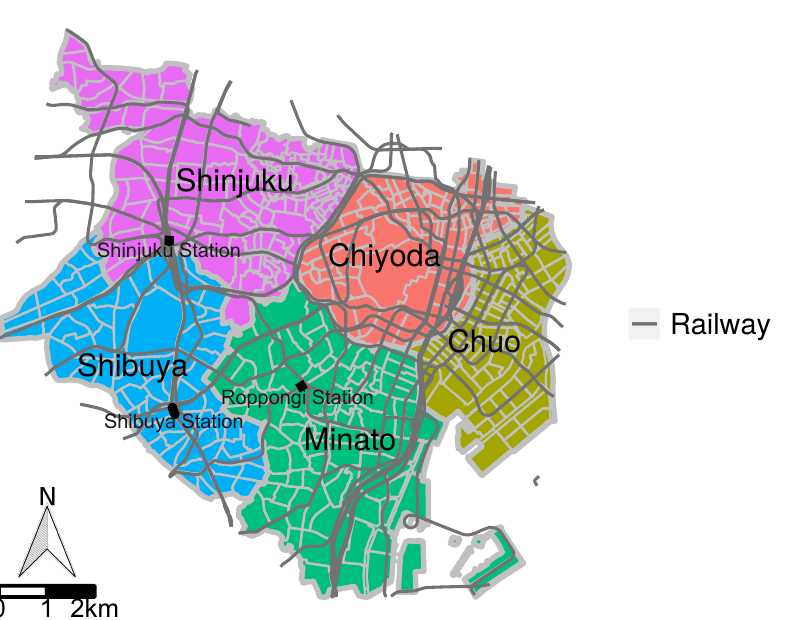
Figure 4. Target area and its spatial partition into district units. Railway networks and several large stations are also shown on the map.